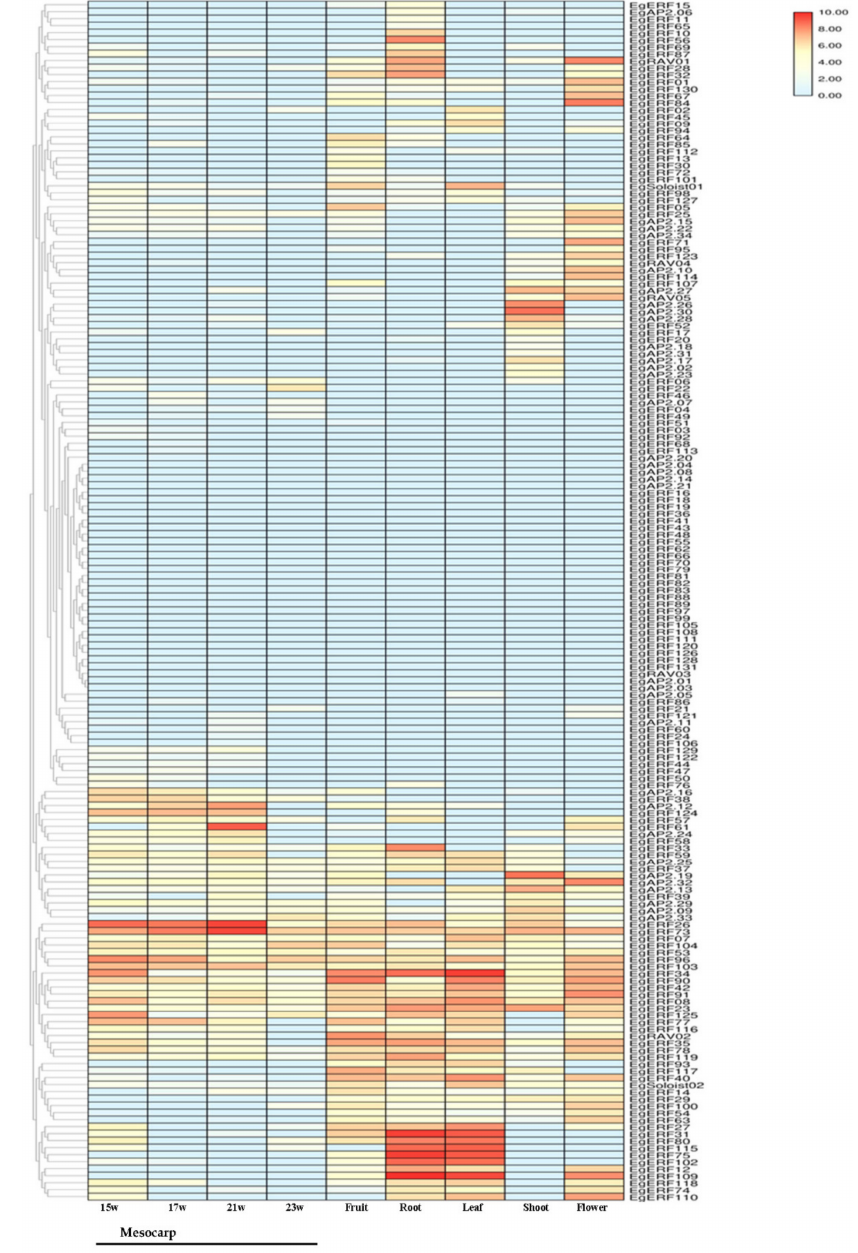
Figure 7. Heatmap for 172 Eg AP2/ERF gene expression in mesocarp (15, 17, 21 & 23 weeks old), root, shoot, leaf, flower, and fruit tissues of oil palm. Transcriptome data representation numbers (SRR190698, mesocarp (15 weeks); SRR190699, mesocarp (17 weeks); SRR190701, mesocarp (21 weeks); SRR190702, mesocarp (23 weeks); SRR851108, flower; SRR851067, fruit; SRR851096, leaf; SRR851071, root; SRR851103, shoot) are labeled in the bottom of the heatmap. The color scale represents the expression levels (low or high) of AP2/ERF